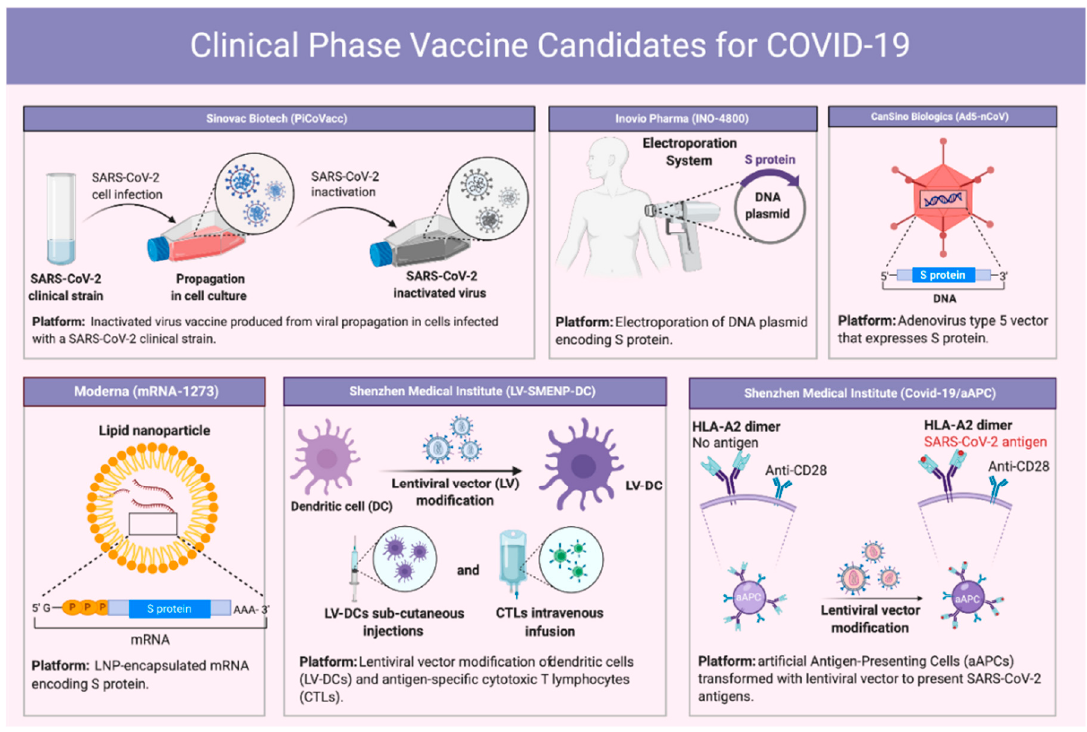
Figure 5. Clinical phase vaccine candidates for COVID-19 .